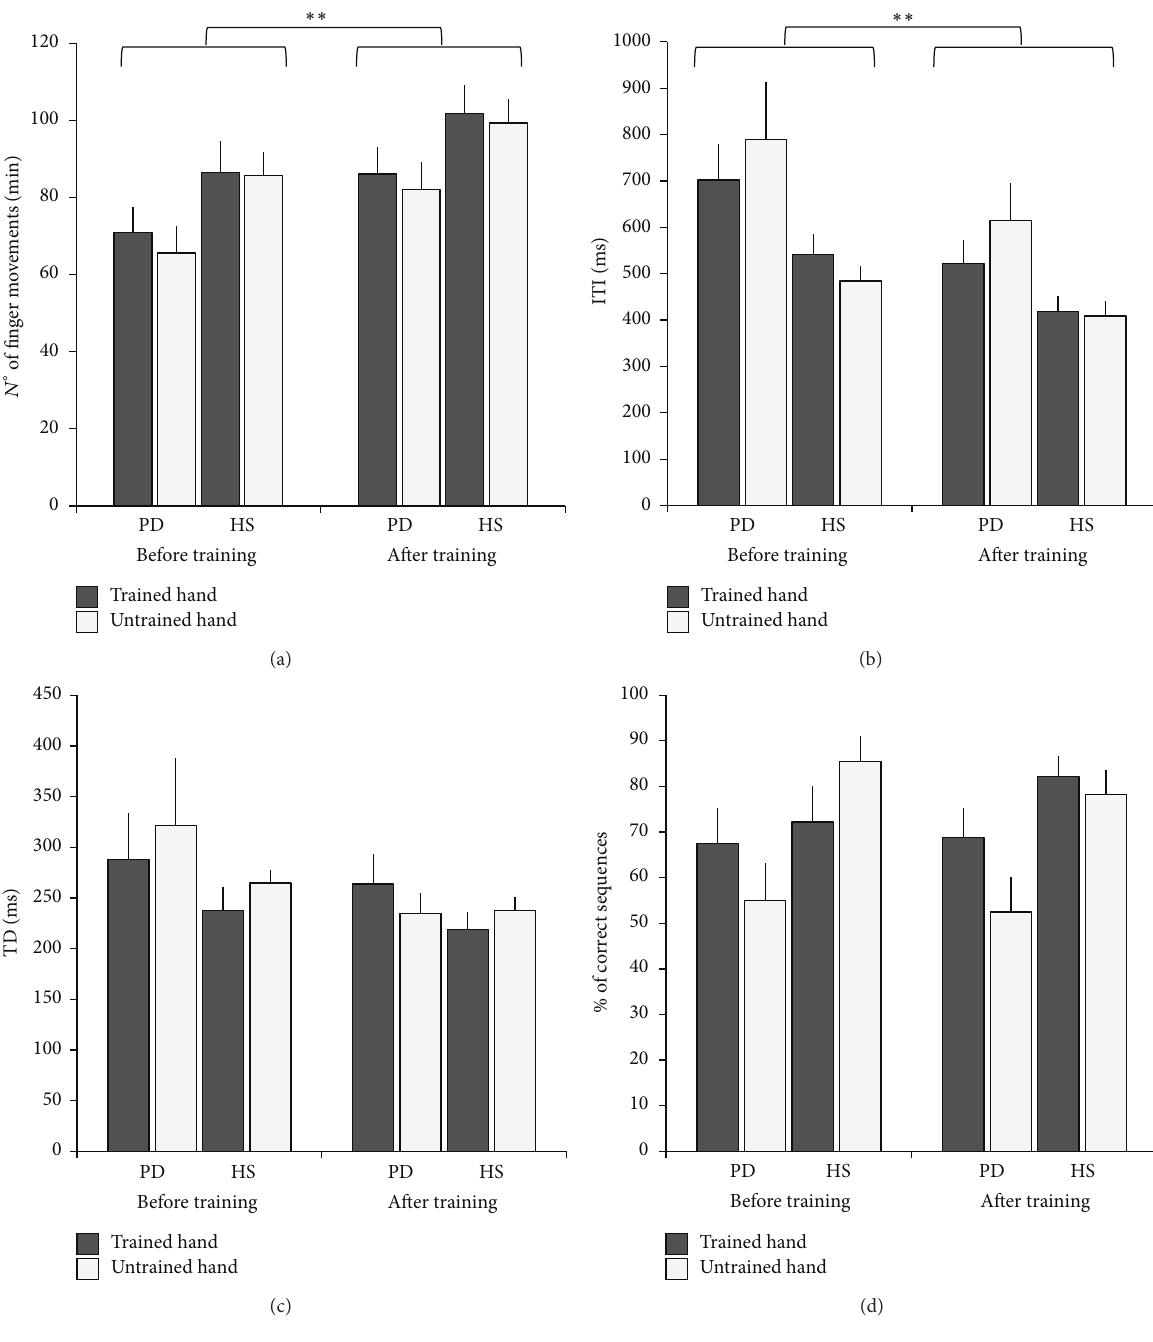
Figure 2: Mirror visual feedback (MVF) training effect on behavioural data. Groups (Parkinson’s disease (PD) patients, healthy subjects (HS)) and hand (trained, untrained) are indicated in the abscissa. Data recorded at baseline (before training) and after MVF training session are reported. Ordinate indicates the mean values of (a) number of finger movements performed in one minute during the assessments; (b) intertapping interval expressed in milliseconds; (c) touch duration expressed in milliseconds; and (d) % of correct sequences. Vertical bars indicate standard error of the mean (SEM). Asterisks indicate that in both groups the number of finger movements performed in one minute significantly increased and ITI significantly decreased after MVF training ( ∗ 𝑝 < 0.05 ; ∗∗ 𝑝 < 0.01